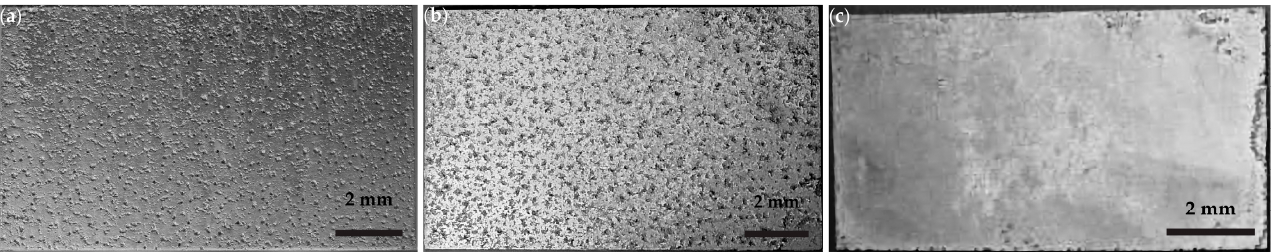
Figure 9. Optical macrographs of surface exposed to the salt–spray test for 24 h: ( a ) alloy AZ31; ( b ) alloy AZ61; and ( c ) WE43-T5.